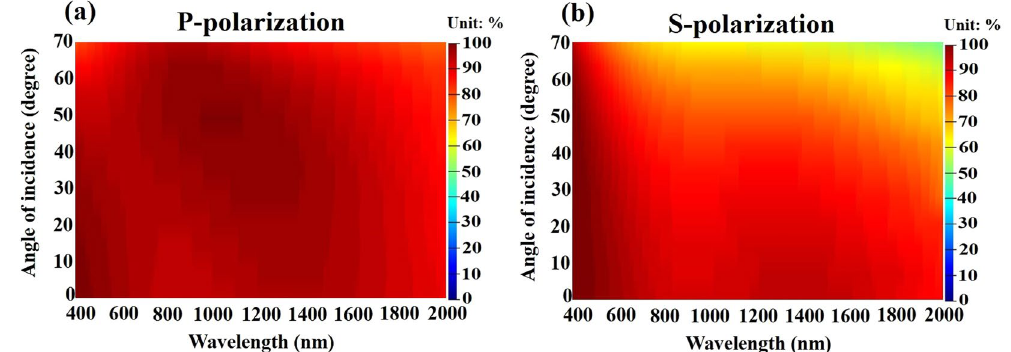
Figure 7. Experimental absorptance as functions of wavelength and angle of incidence for Air/SiO 2 (80 nm)/ Cr(6